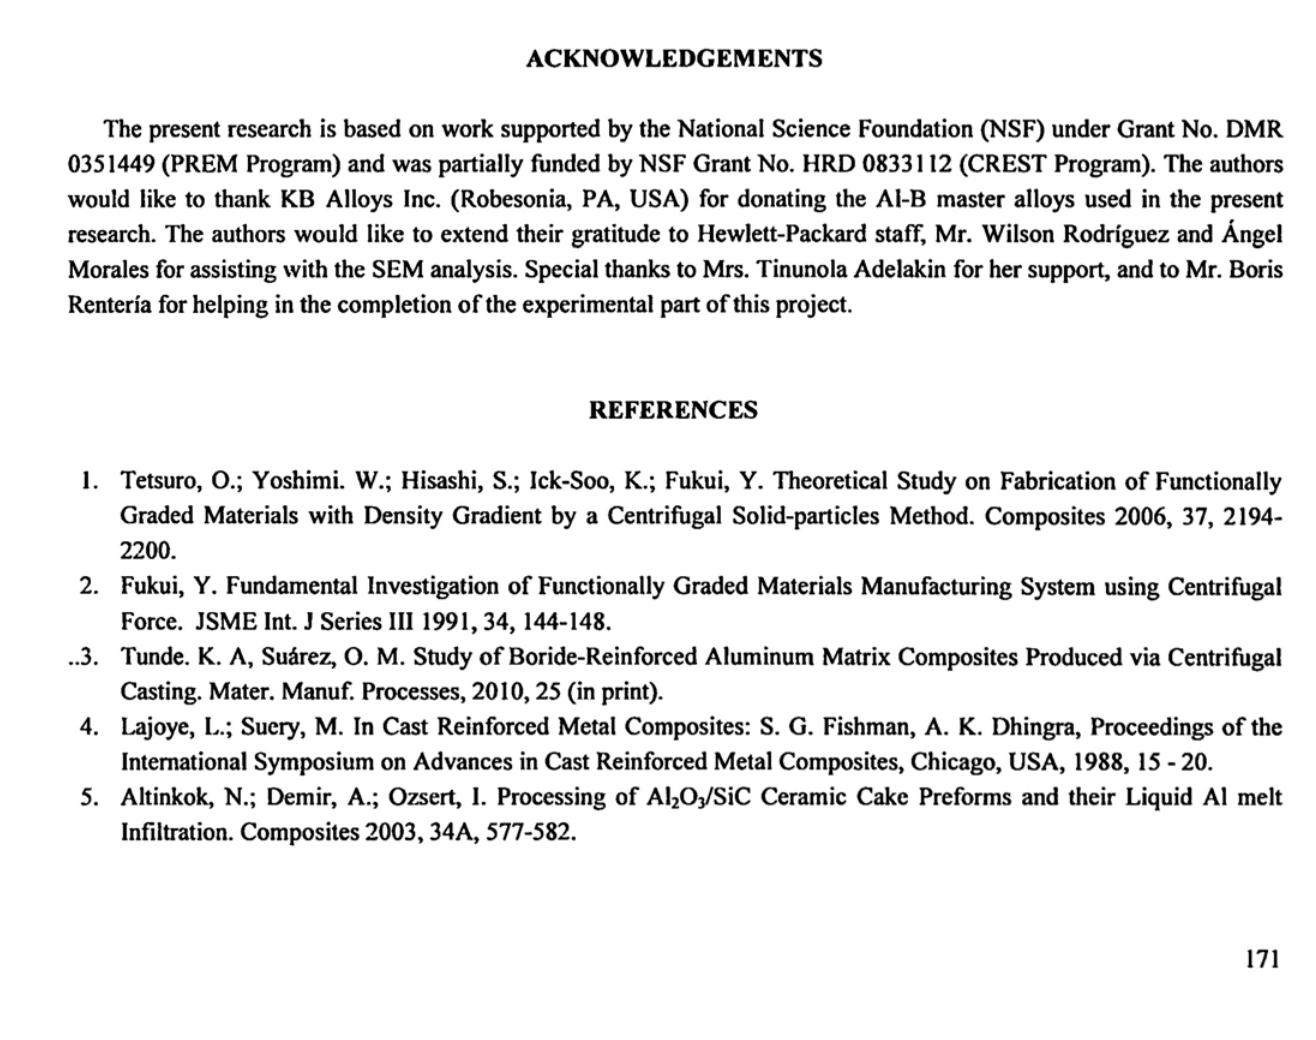
Fig. 15: Micrographs of Al-B master alloy with various treatments: (a) As received; (b) Annealed at 400°C; (c) Melt treated at